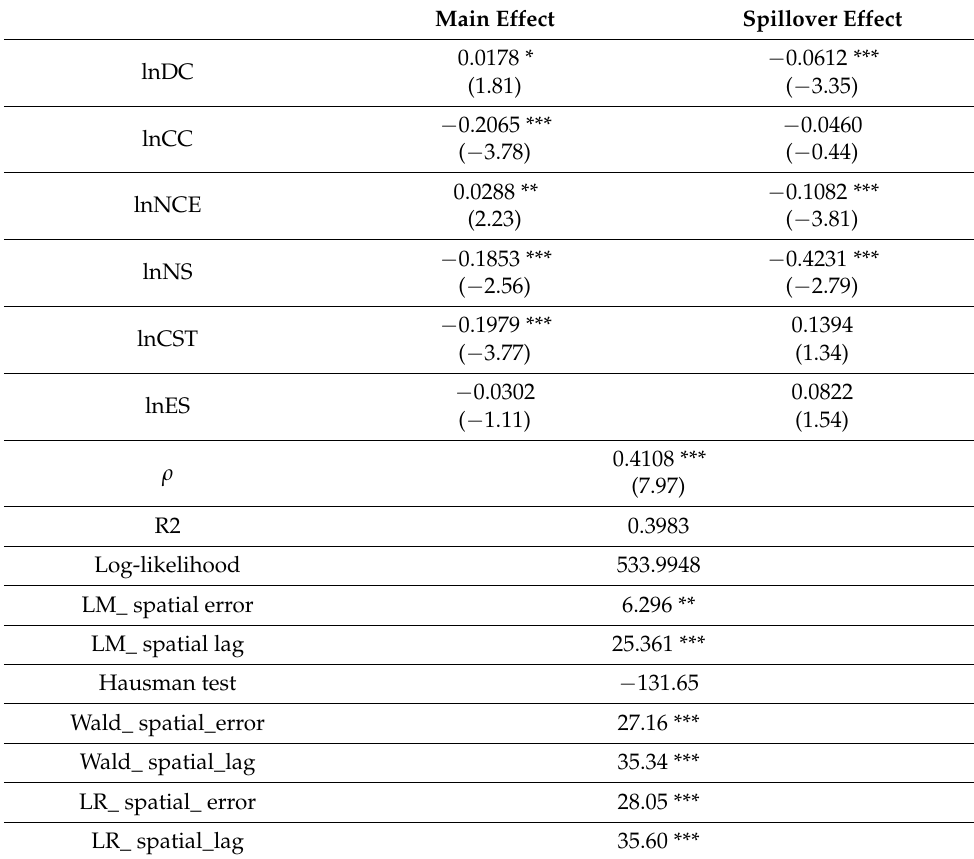
Table 4. Spatial Durbin model test and estimation results.